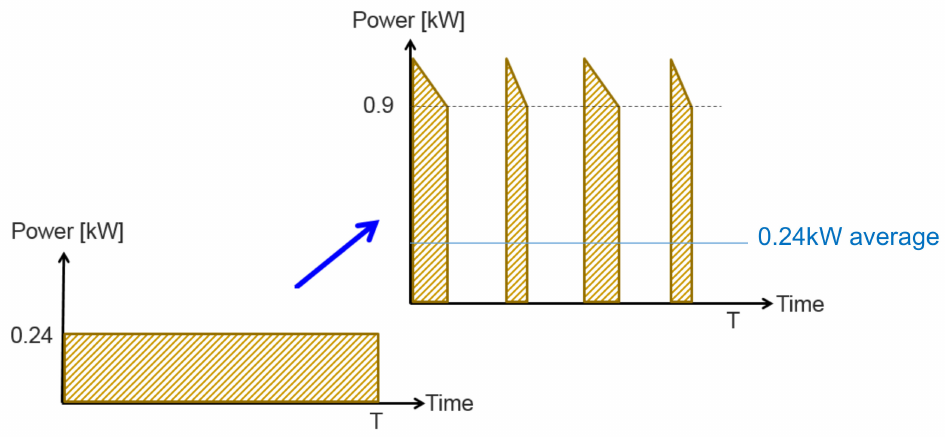
Figure 5. Continuous to ON / OFF operational principle